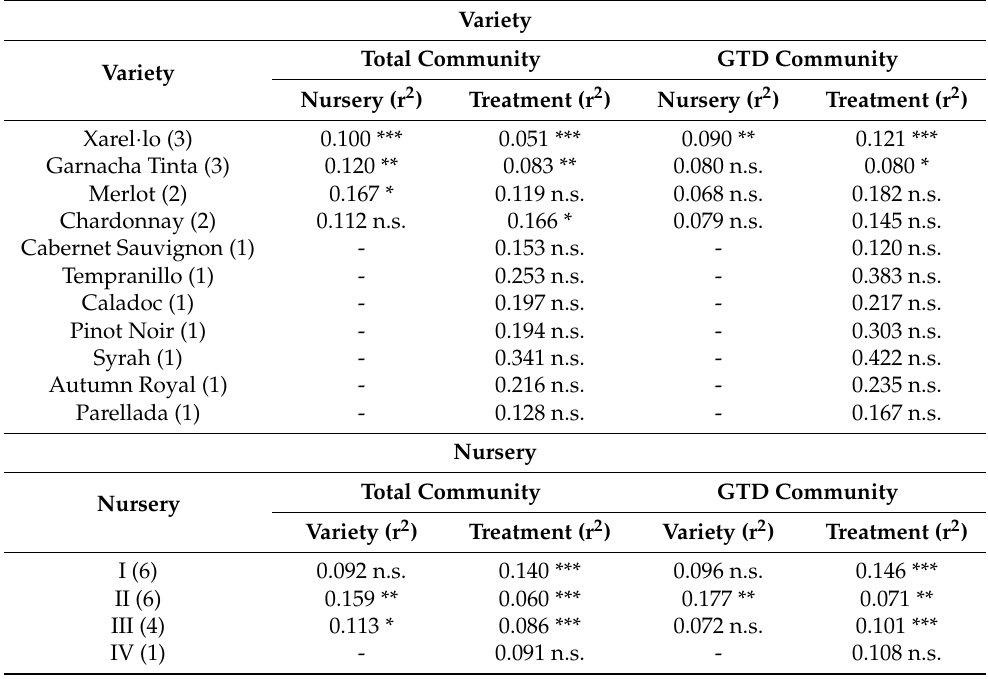
Table 5. Contribution of each variety (top) to variation (r 2 ) by nursery and treatment for total and GTD communities in graft unions and of each nursery (bottom) to variation (r 2 ) by variety and treatment. The annotation following the r 2 value indicates the significance level: *** <0.001, ** <0.01, * <0.05, n.s. = not significant (>0.05). Numbers in parentheses indicate the number of nurseries that supplied a particular variety (top) and the number of varieties supplied by each nursery